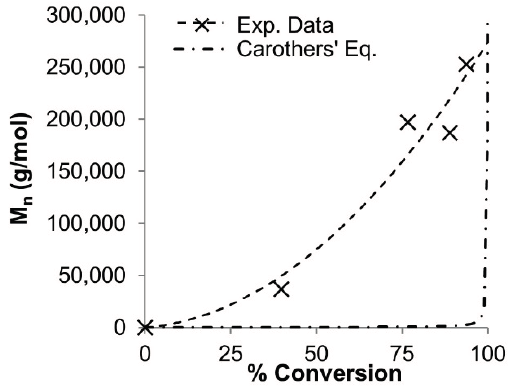
Figure 2. DODT oxidative polymerization data (dashed line) plotted against the Carothers equation (dash-dot)